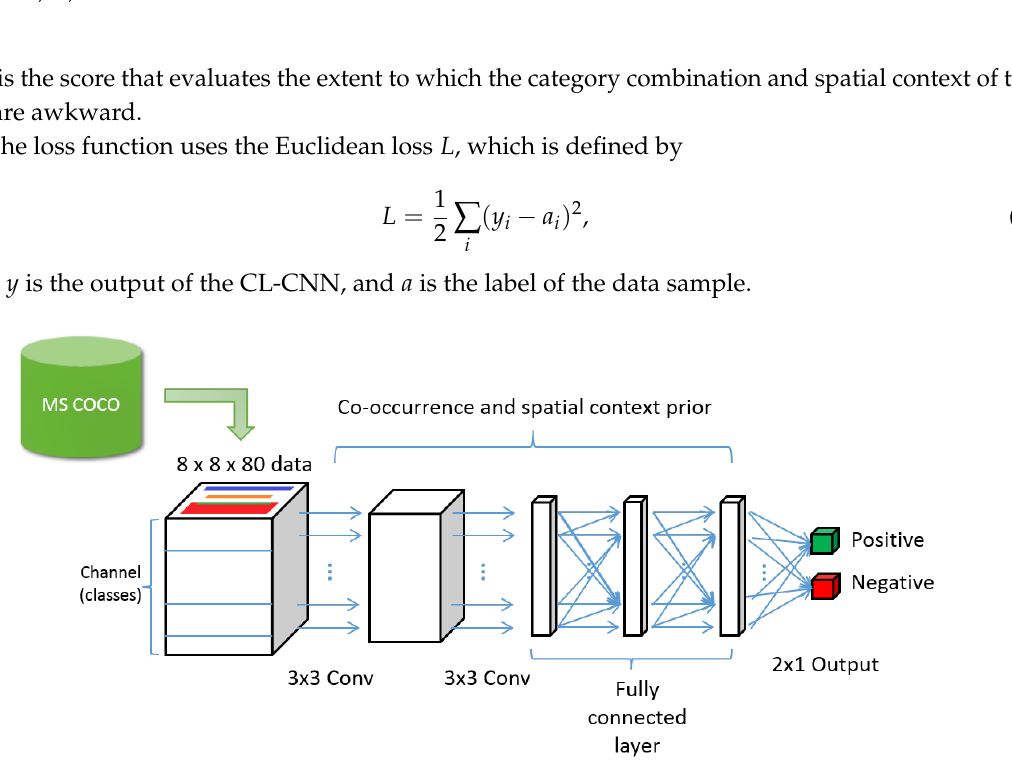
Figure 4. Overall structure of the context-learning convolutional neural networks. The network receives the encoded input data that consists location and label information. The input passes through two convolutional layers and three fully connected